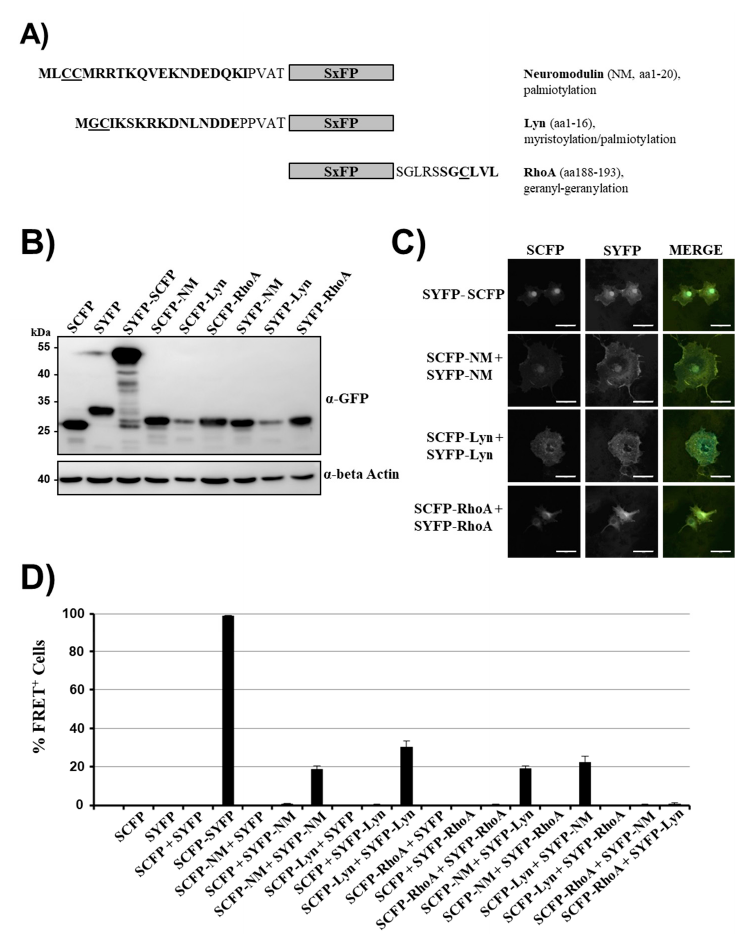
Figure 1. Membrane localization of non-interacting proteins can be sufficient for fluorescence resonance energy transfer (FRET). ( A ) Schematic presentation of super yellow fluorescent protein (SYFP) and super cyan fluorescent protein (SCFP) fusion proteins (SxFP) containing membrane targeting signals. The underlying cellular proteins, the relevant amino acid sequences and their respective modification for membrane targeting are indicated. ( B ) For analysis of expression of fusion proteins, 293T cells were transfected with the indicated plasmids and protein expression analyzed by Western blot, employing an anti-green fluorescent protein (GFP) antibody. Staining with anti- β -actin antibody served as loading control. Similar results were obtained in two separate experiments. ( C ) Immunofluorescence analysis of SxFP fusion proteins. Plasmids were transfected into COS-7 cells and protein expression was analyzed by confocal microscopy. The results were confirmed in two separate experiments. Scale bars indicate 50 µm. ( D ) 293T cells were transiently transfected with the indicated plasmid combinations and analyzed by FACS-FRET assay at 48 h post transfection. The results of a single experiment performed with triplicate samples are shown. Error bars indicate standard deviation (SD). The results are representative of 2–4 separate experiments. See Supplementary Figure S2 for representative primary FRET/CFP plots.